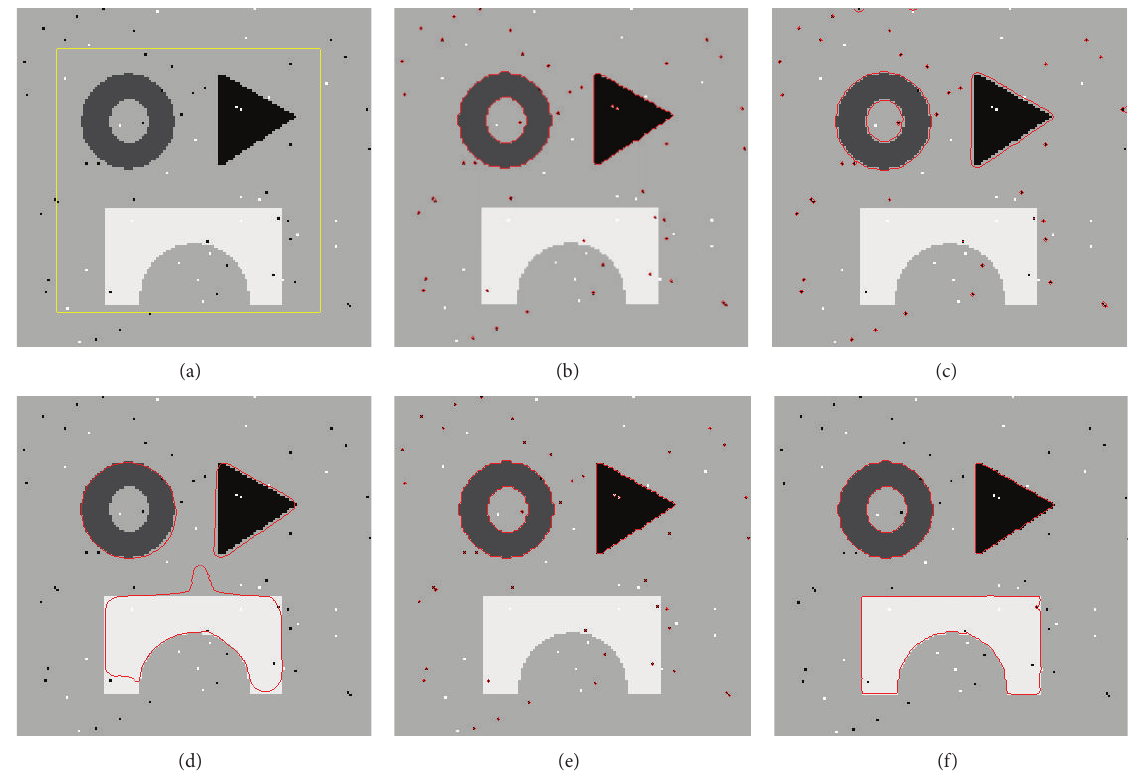
Figure 9: Segmentation results on the synthetic image corrupted by salt and pepper noise: (a) the initial contour, (b) the CV model result, (c) the GACV model result, (d) the DRLSE model result, (e) the FAC model result, and (f) the LFAC model